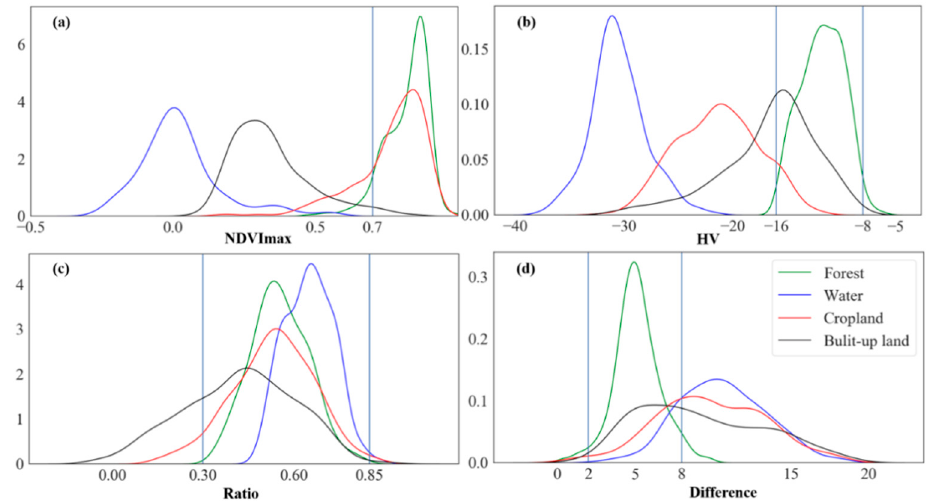
Figure 4. The annual NDVI maximum and backscatter signatures of four typical land cover types: ( a ) NDVI max , ( b ) HV, ( c ) Ratio, and ( d ) Difference. ( a ) NDVI max , ( b ) HV, ( c ) Ratio, and ( d )